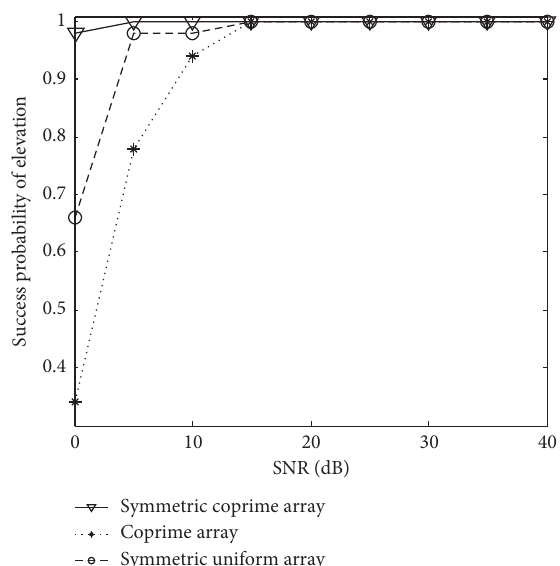
Figure 12: The probability of success of elevation.